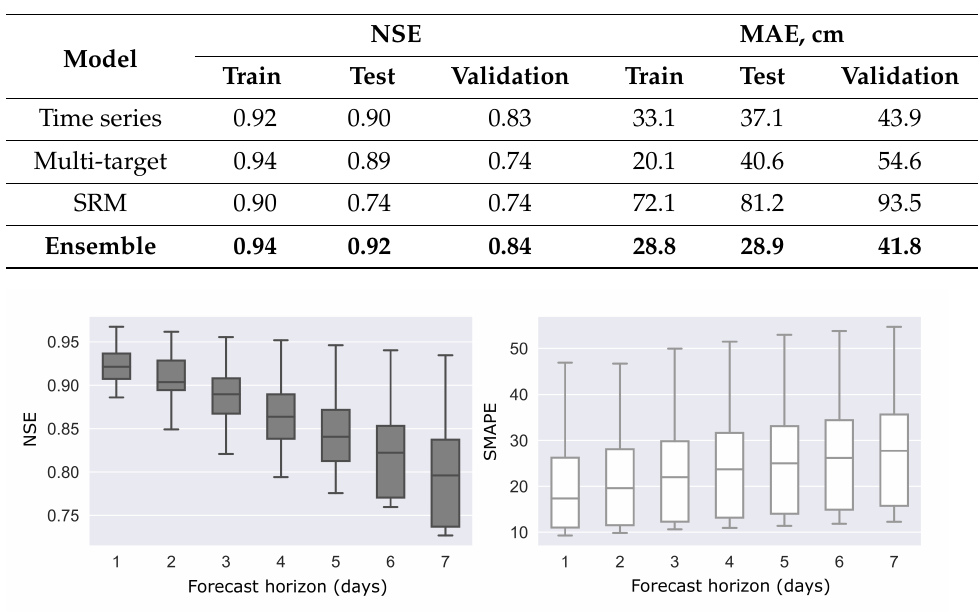
Figure 16. Error metrics (NSE and SMAPE) of ensemble model for several forecasting horizons.